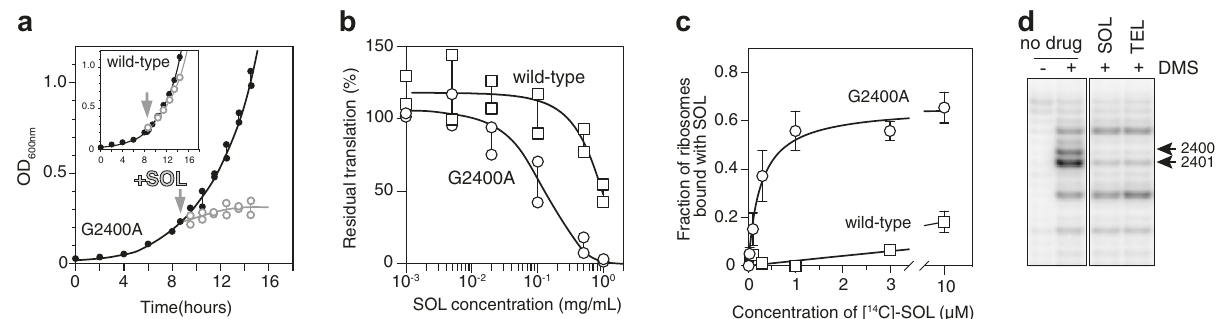
Fig. 2 Macrolide antibiotics bind to the mutant yeast ribosome and inhibit protein synthesis and cell growth. a SOL arrests growth of the G2400A mutant S. cerevisiae cells. Plots show the growth of mutant cells in the absence of the drug ( fi lled black circles) or after addition of 8× MIC of SOL (open gray circles). The inlet shows that wt yeast is resistant to SOL. The graphs represent results of two independent experiments with individual data points indicated. b Residual protein synthesis in wt (squares) and G2400A mutant (circles) yeast cells exposed to SOL. Translation was assessed by measuring incorporation of L -[ 35 S]-methionine into polypeptides after exposure of cells for 10 min to different concentrations of SOL. L -[ 35 S]-methionine incorporation in the untreated mutant cells was set to 100%. The data points of two independent experiments are indicated by squares (wt) and circles (G2400A mutant). c Equilibrium binding of [ 14 C]-SOL to wt (squares) or G2400A mutant (circles) ribosomes. The data are presented as mean values of three independent experiments; error bars show standard deviation. d SOL and TEL protect A2400 and A2401 of the 25S rRNA from chemical modi fi cation. The gel shows the primer extension analysis the 25S rRNA extracted from the untreated or dimethyl sulfate (DMS)-modi fi ed G2400A 80S ribosomes incubated without or with the antibiotics. The position of the cDNA bands corresponding to the nucleotide residues A2400 and A2401 are indicated by the arrows. The chemical modi fi cation of wt ribosomes in the presence of SOL and TEL and that of mutant ribosomes in the presence of ERY and azithromycin are shown in Supplementary Fig. 2b, c, respectively. The uncropped gel can be found in the Source data fi le. The result is a typical representative of two independent